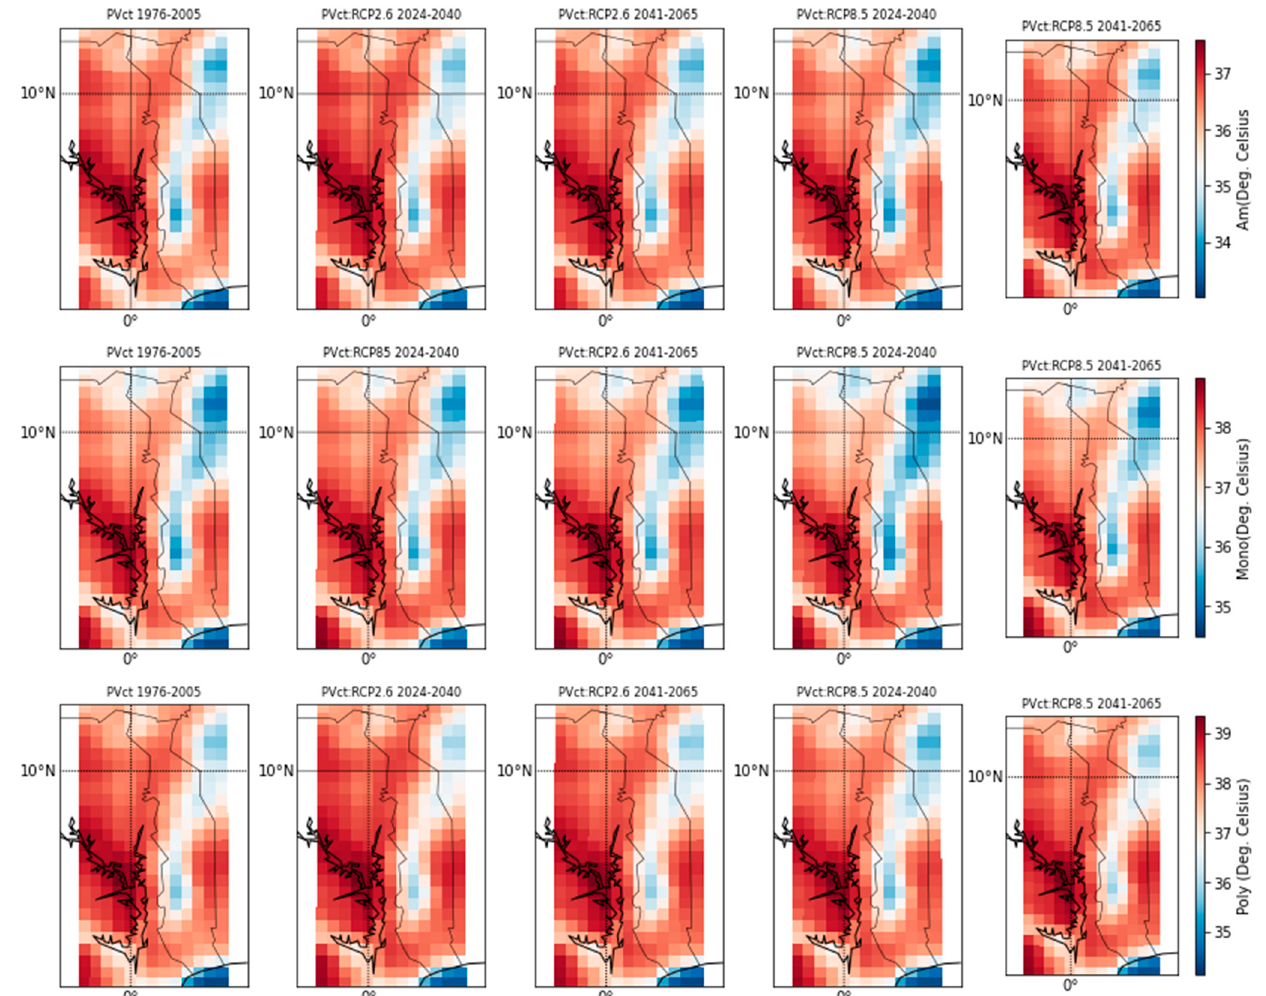
Figure 7. Estimated annual and spatial PVct variations, Togo.